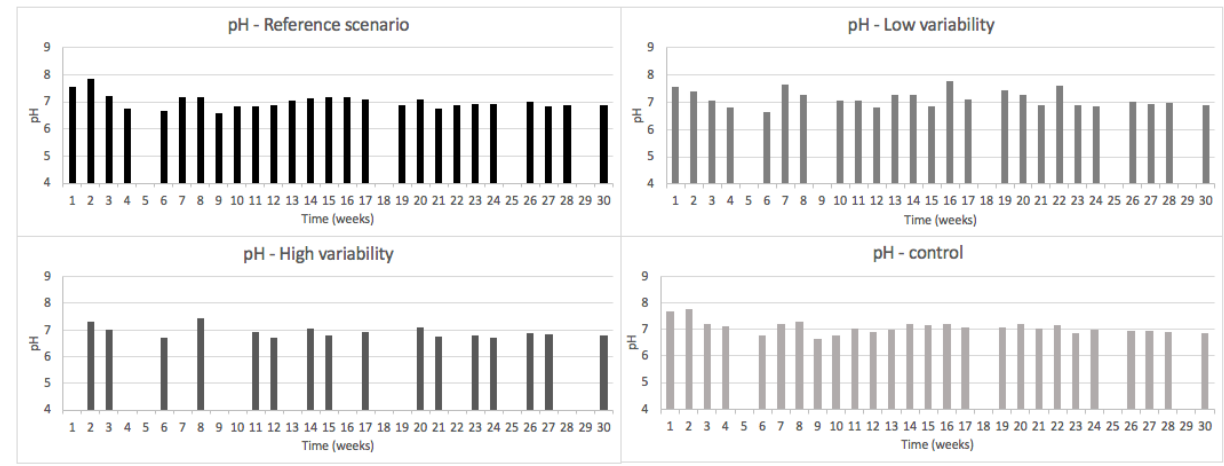
Figure 5. pH evolution for all tested scenario over the 30 weeks (10 cycles) of the